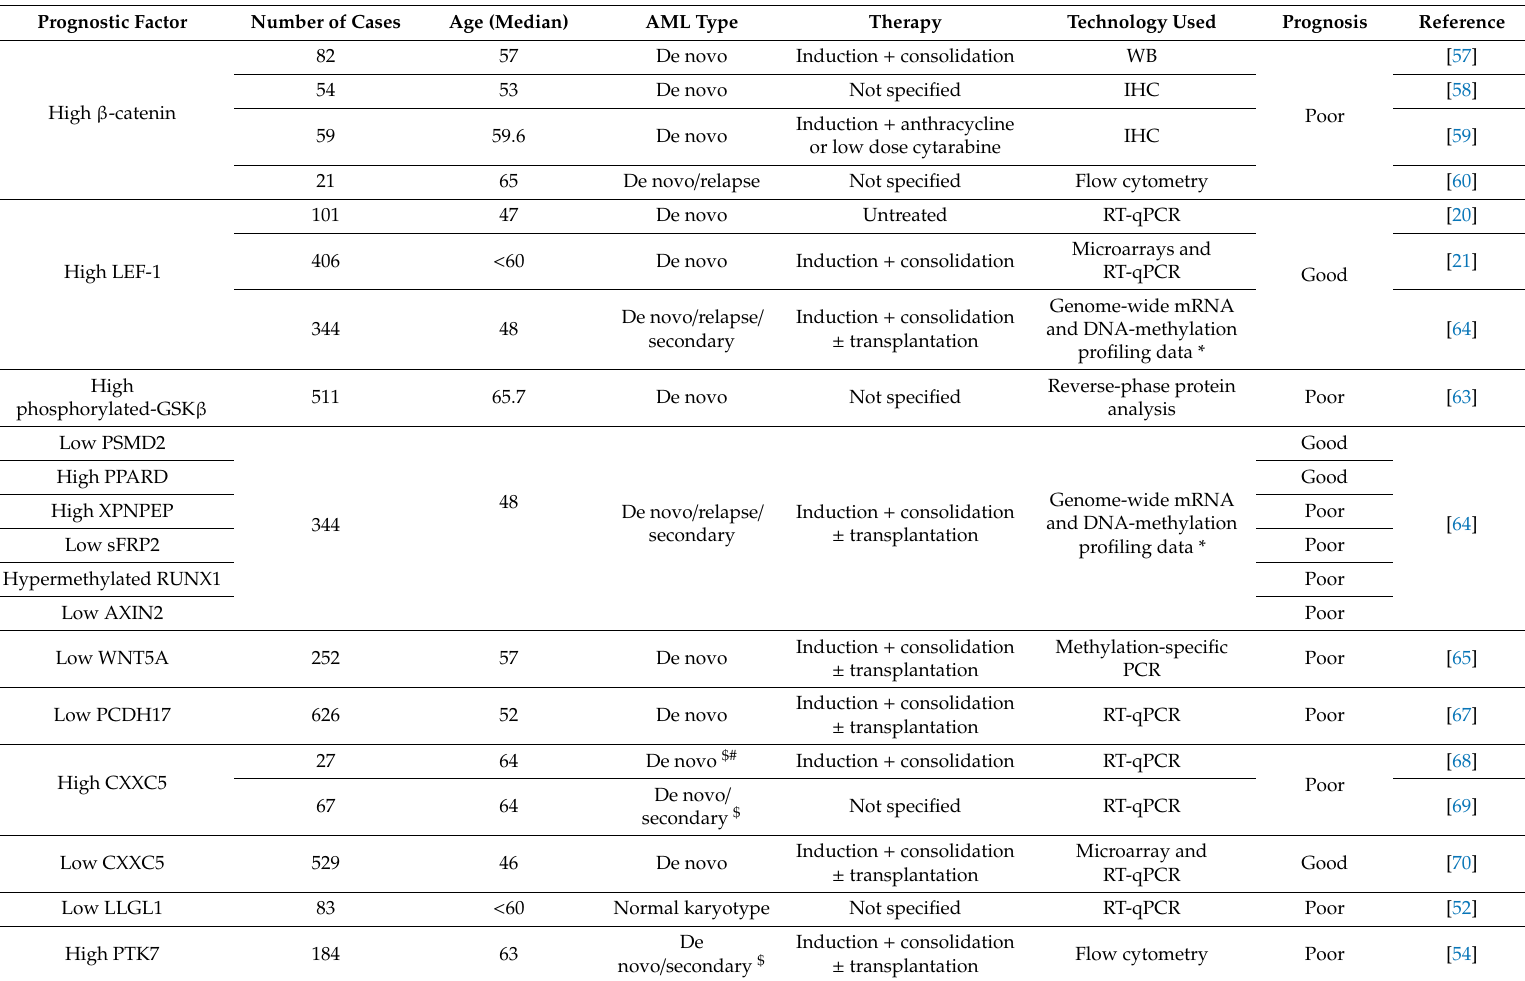
Table 2. Wnt signalling and Wnt signalling-modifying or target molecules with prognostic